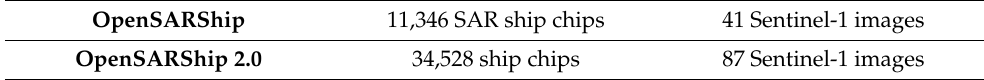
Table 2. The statistics of OpenSARShip and OpenSARShip 2.0. OpenSARShip OpenSARShip